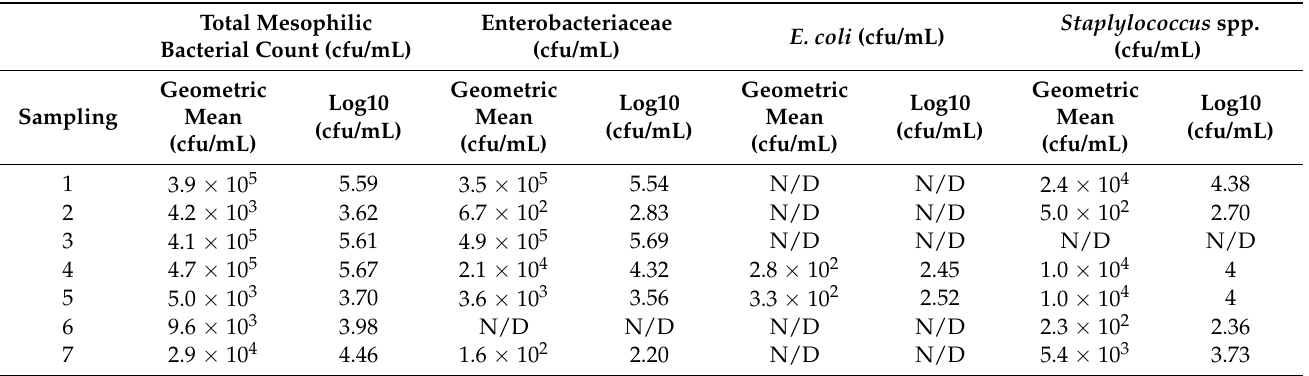
Table 1. Total mesophilic bacterial count, Enterobacteriaceae, E. coli , and Staphylococcus spp. counts in raw milk samples (geometric mean).